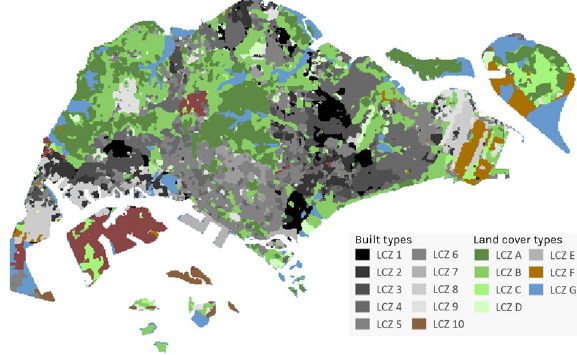
Figure 2. Preliminary LCZ classification map in